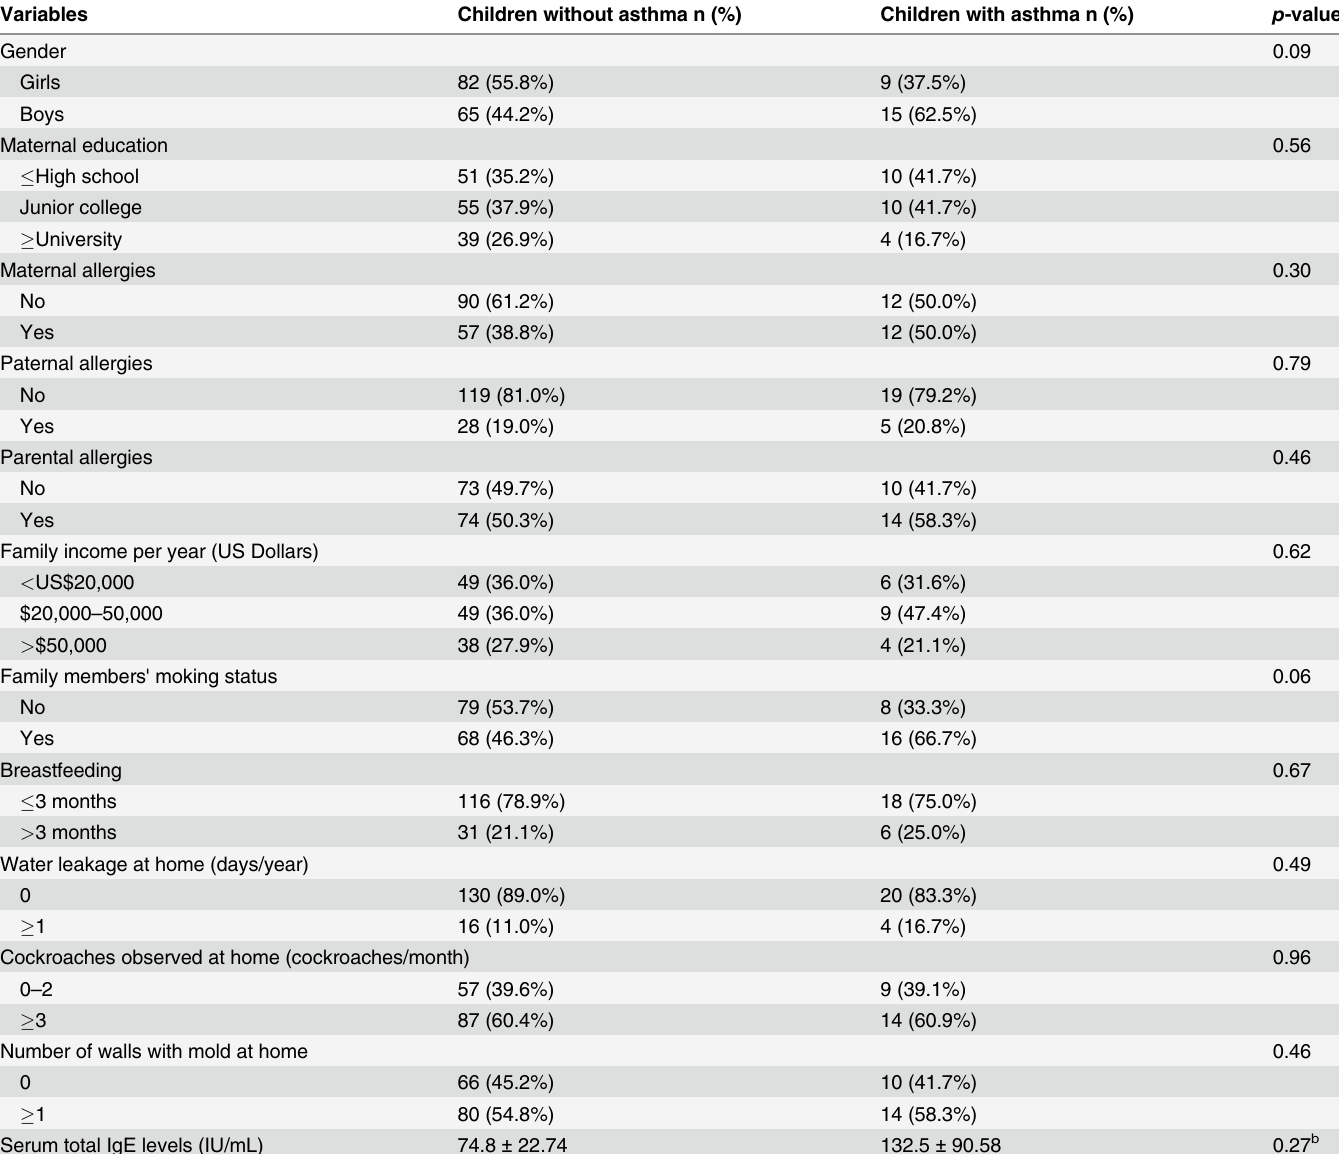
Table 2. Characteristics of children at 8 years of age classified by asthma status (n = 171).